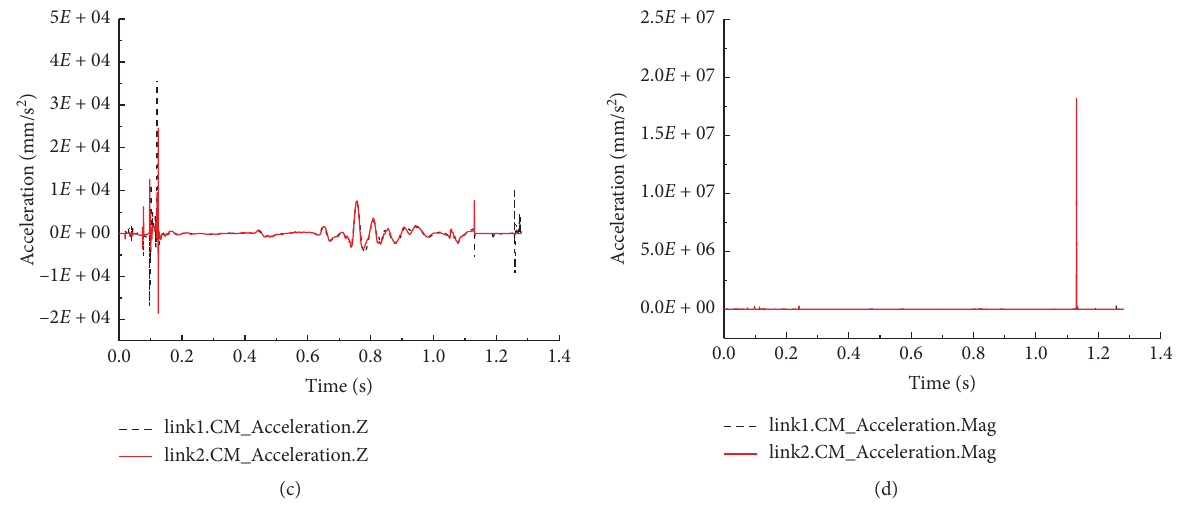
Figure 18: Link acceleration change curve at the chain rupture position. (a) Acceleration in the X direction. (b) Acceleration in the Y direction. (c) Acceleration in the Z direction. (d) Acceleration amplitude.